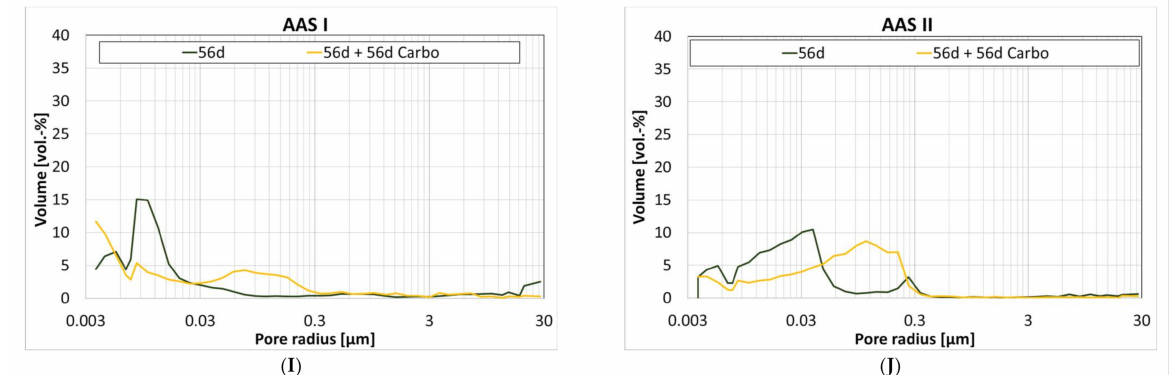
Figure 5. Pore size distributions of hydrated and carbonated alternative binders. ( A ) Pore size distribution of hydrated and carbonated reference cement (Ref I); ( B ) Pore size distribution of hydrated and carbonated composite cements (LD); ( C ) Pore size distribution of hydrated and carbonated composite cements (CC I); ( D ) Pore size distribution of hydrated and carbonated composite cements (CC II); ( E ) Pore size distribution of hydrated and carbonated CSA cement; ( F ) Pore size distribution of hydrated and carbonated C-S-H binder; ( G ) Pore size distribution of hydrated and carbonated AAMs (Geo FA); ( H ) Pore size distribution of hydrated and carbonated AAMs (Geo MK); ( I ) Pore size distribution of hydrated and carbonated AAMs (AAS I); ( J ) Pore size distribution of hydrated and carbonated AAMs (AAS II).